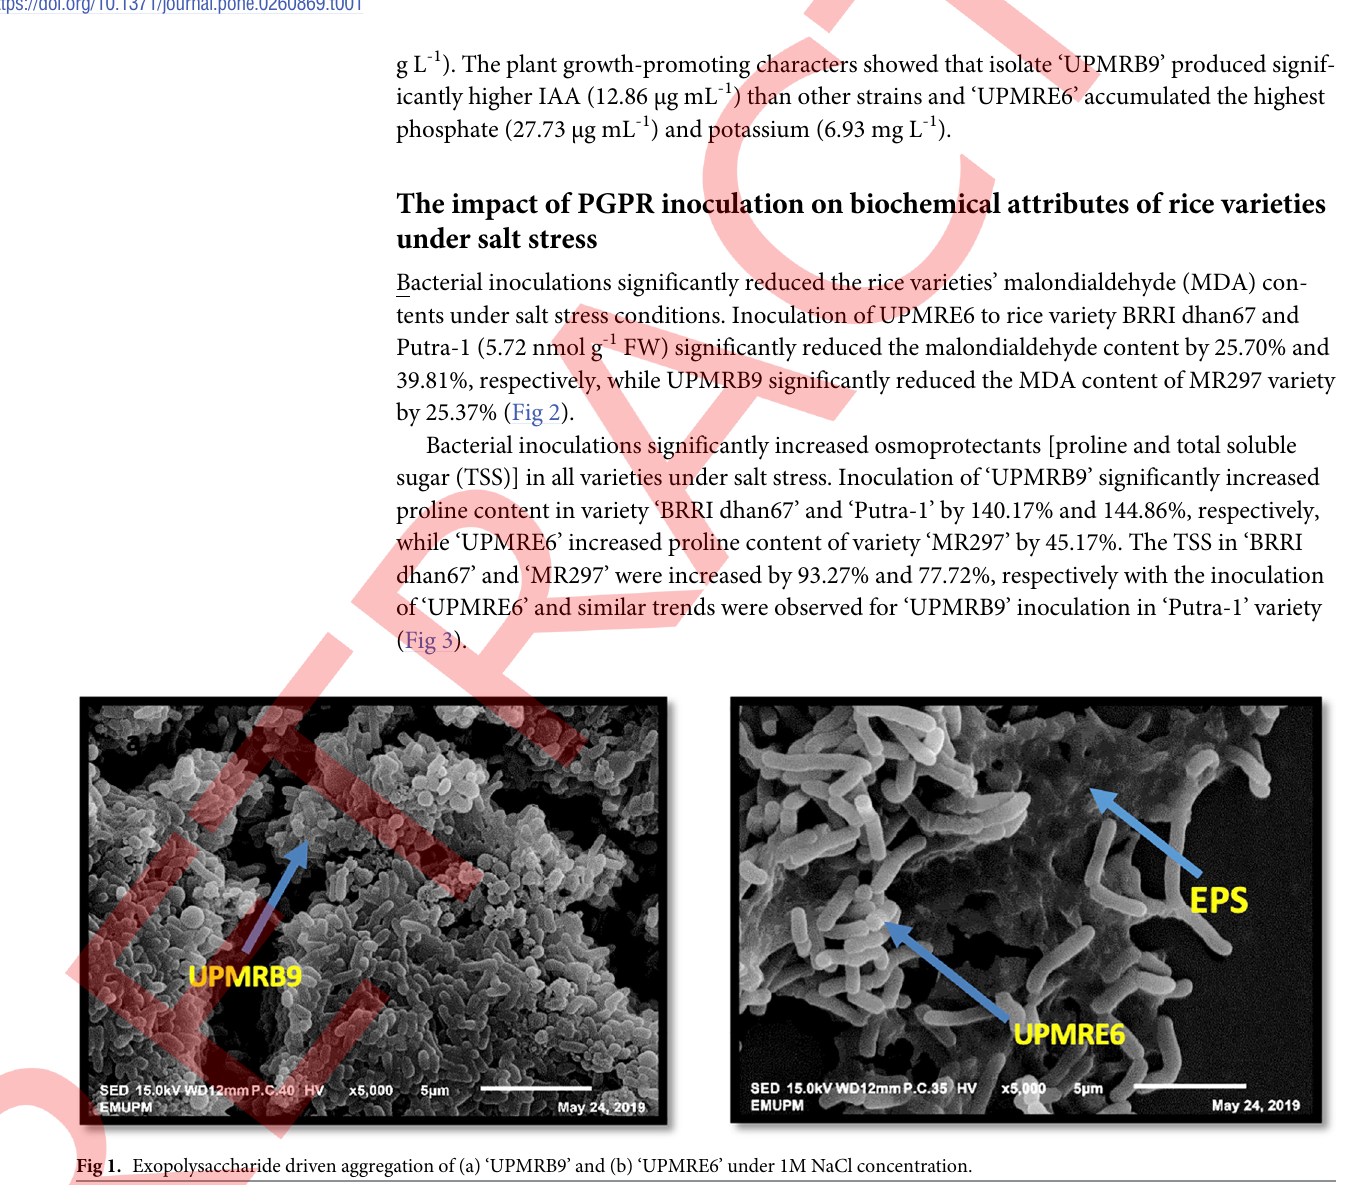
Fig 1. Exopolysaccharide driven aggregation of (a) ‘UPMRB9’ and (b) ‘UPMRE6’ under 1M NaCl concentration.